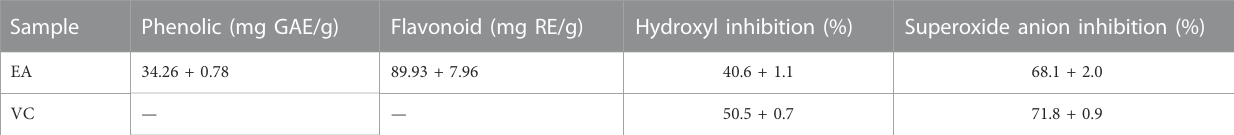
TABLE 1 Phenolic content, fl avonoid content, and radical-scavenging assays of the ethyl-acetate fraction from the cinnamon cortex extract. Sample